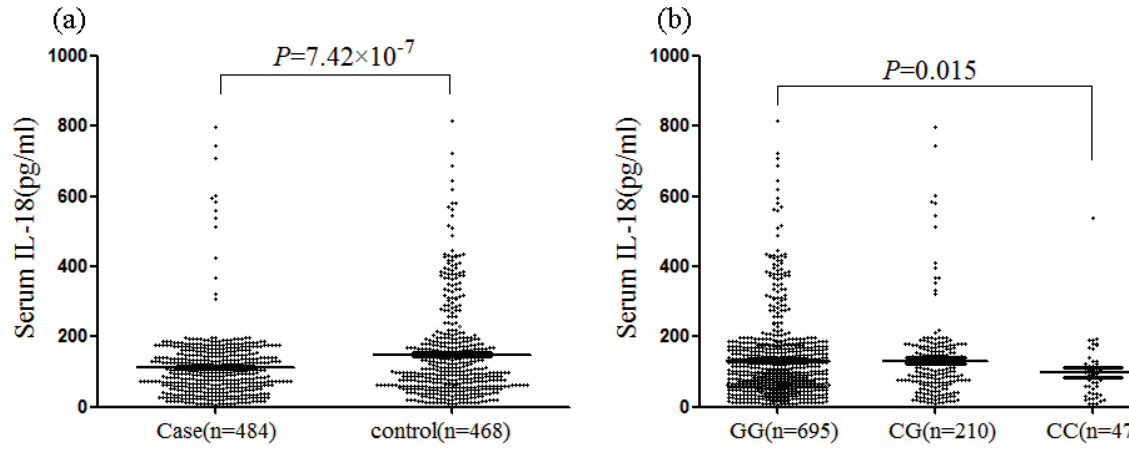
Figure 1. Comparison of serum IL-18 levels among IL18 genotypes. Serum IL-18 was measured using a human IL-18 enzyme-linked immunosorbent assay. Data were expressed as means ± SD. Statistical differences were performed using Mann-Whitney U test for variance non-homogeneity. ( a ) Serum IL-18 concentrations in cases and controls; ( b ) Serum IL-18 levels according to rs187238 genotypes among cases and